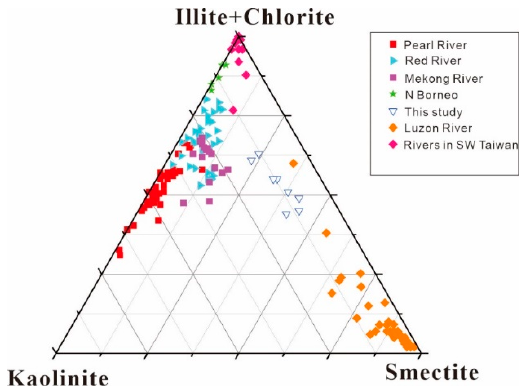
Figure 4. Ternary diagram of clay minerals of surface sediments from the study area compared with those from the adjacent regions.